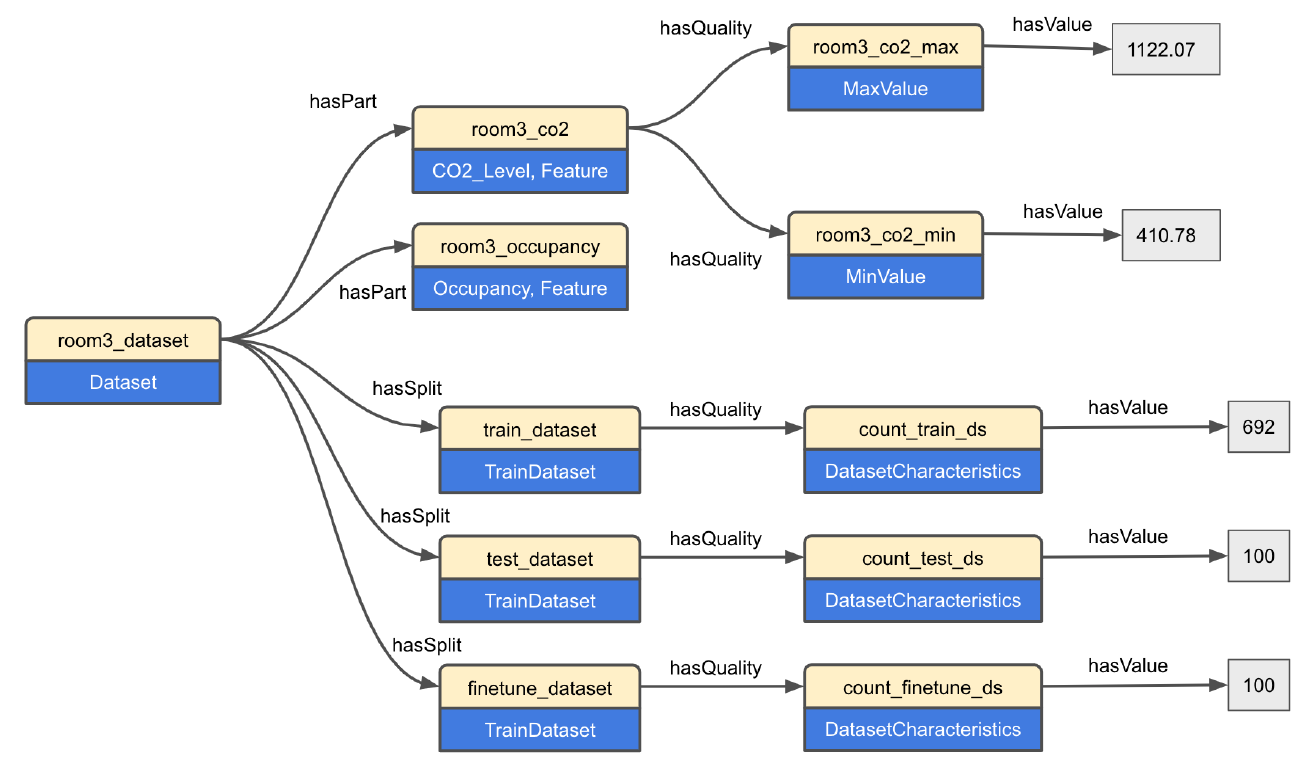
Figure 5. Part of the knowledge graph describing dataset features such as occupancy, CO 2 , and their corresponding